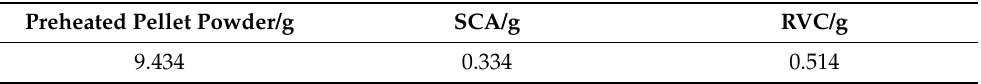
Table 4. The respective weights of the initial reactants for simulating deposit formation. Preheated Pellet